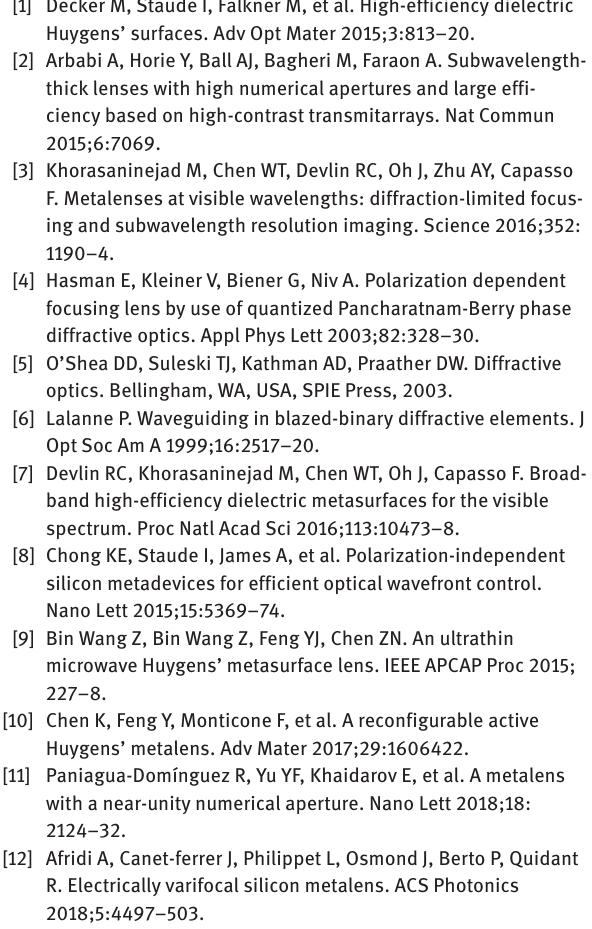
power in first diffraction order; (b) 50 × objective removed – gives the power in the zero order; and (c) metalens removed but aperture stop still in place – gives the total power, which is our reference